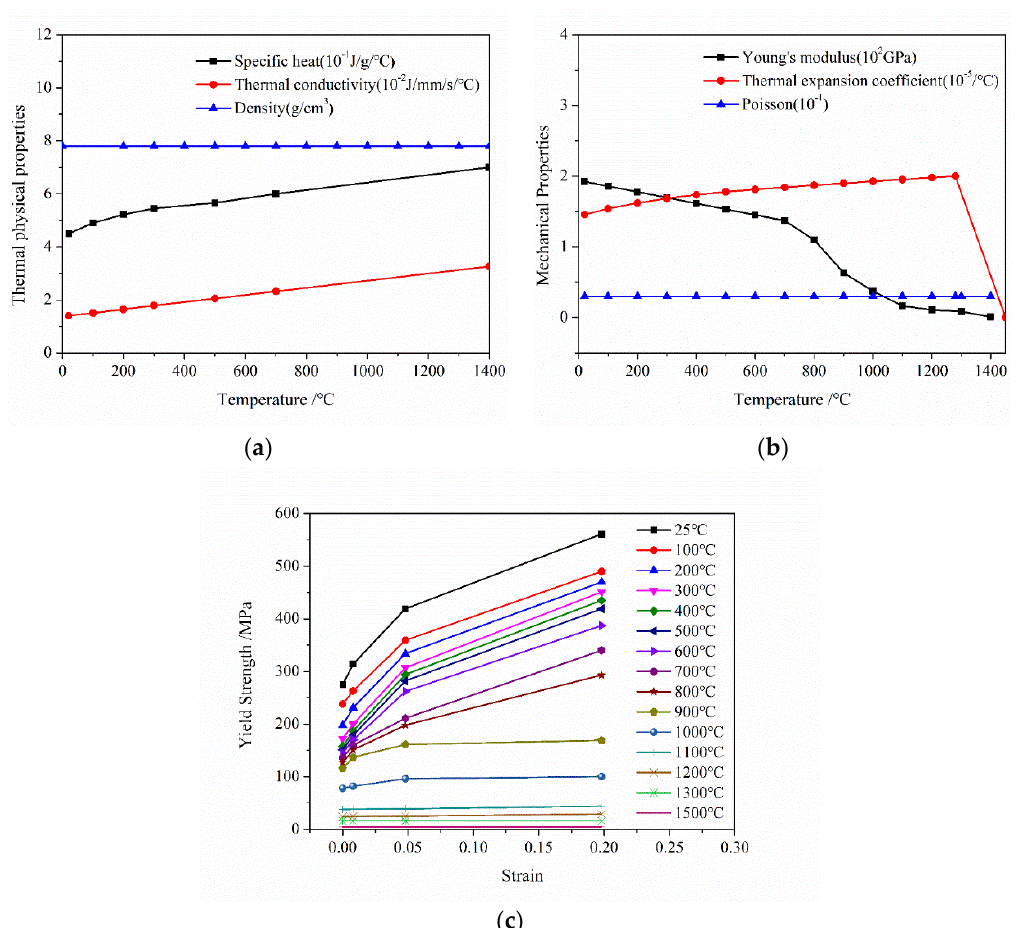
Figure 6. Temperature dependency of ( a ) thermal physical and ( b ) mechanical parameters, and ( c ) yield strength of 347 L steel.